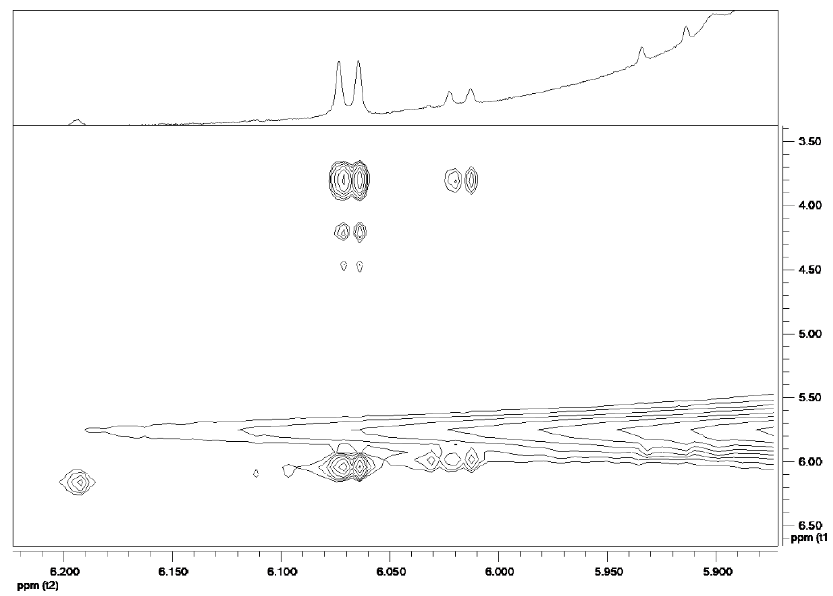
Figure 3. TOCSY spectrum showing correlation pattern of ribosylic moieties.